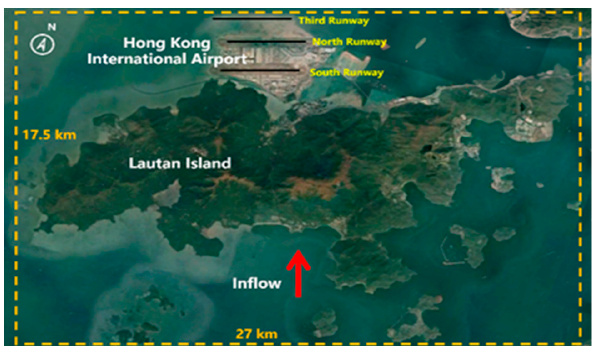
Figure 4. Hong Kong International Airport and surrounding terrain.